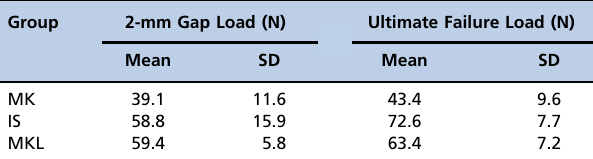
Figure 2 - Porcine tendons repaired using various suture techniques. A. Modified Kessler with peritendinous suture (MK); B. Interlock suture with peritendinous suture (IS); C. Modified Kessler-loop lock suture with peritendinous suture (MKL); D. Repaired porcine tendon in mechanical testing; E. Suture failure in mechanical testing; F. Load-deformation curve. Table 1 - The 2-mm gap loads and ultimate failure loads for three suture techniques. Group 2-mm Gap Load